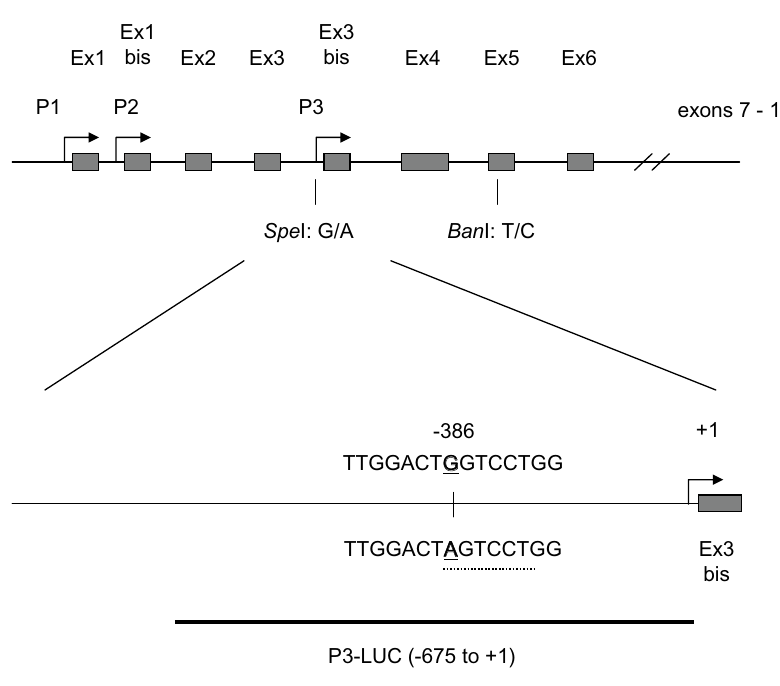
Figure 1 Map of the 5' TP73 exons showing the SNPs utilized in this study. The arrows represent promoter sequences and the rectangles exons. The region of DNA containing the -386G/A SNP is magnified in the lower panel. The SNP is underlined and the dotted line indicates the variant progesterone receptor binding site (AGTCCT, consensus sequence A/TGTYCT) that